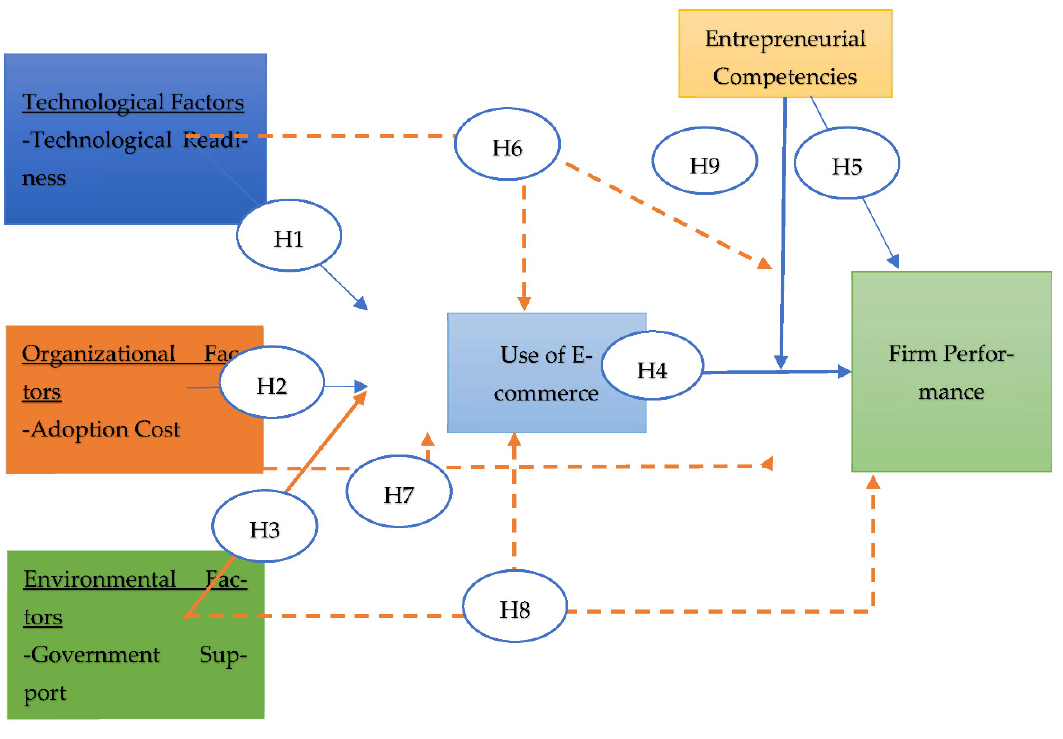
Figure 1. Theoretical framework.